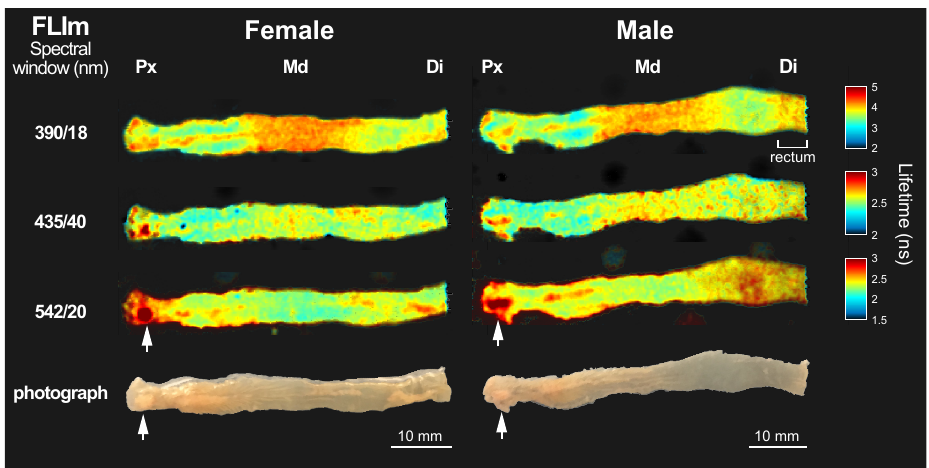
Figure 1. Fluorescence lifetime maps of exposed colon lumen from two representative samples, a female and a male subject, at spectral windows 390/18 nm, 435/40 nm, and 542/20 nm. The corre- sponding photograph of each colon luminal surface is included in the bottom row. The color bar for the lifetime maps of each spectral band has been adjusted to maximize contrast. White arrowheads point to fat accumulations in the samples. Three anatomical regions are identified as proximal (Px), middle (Md), and distal (Di) colon. This male sample also shows distinct lifetime in the